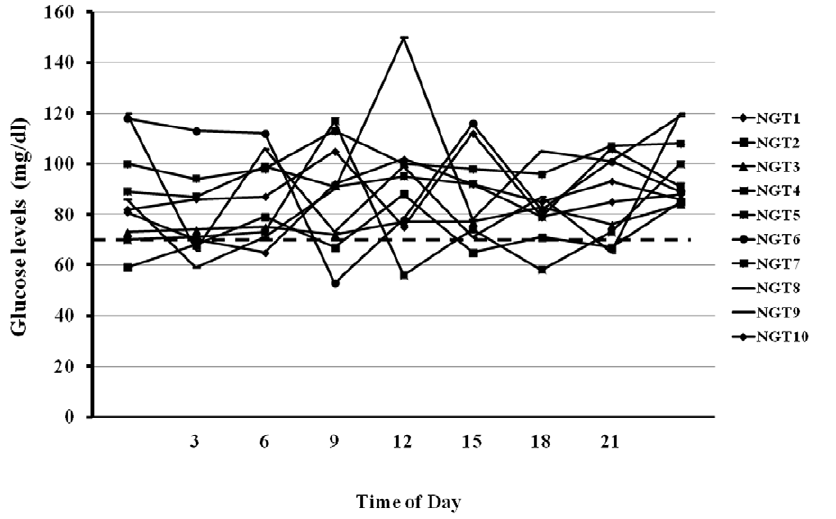
Figure 1. Twenty-four-hour glucose profiles of 10 representative individuals with NGT. Dashed line indicates the 70 mg/dl glucose threshold.